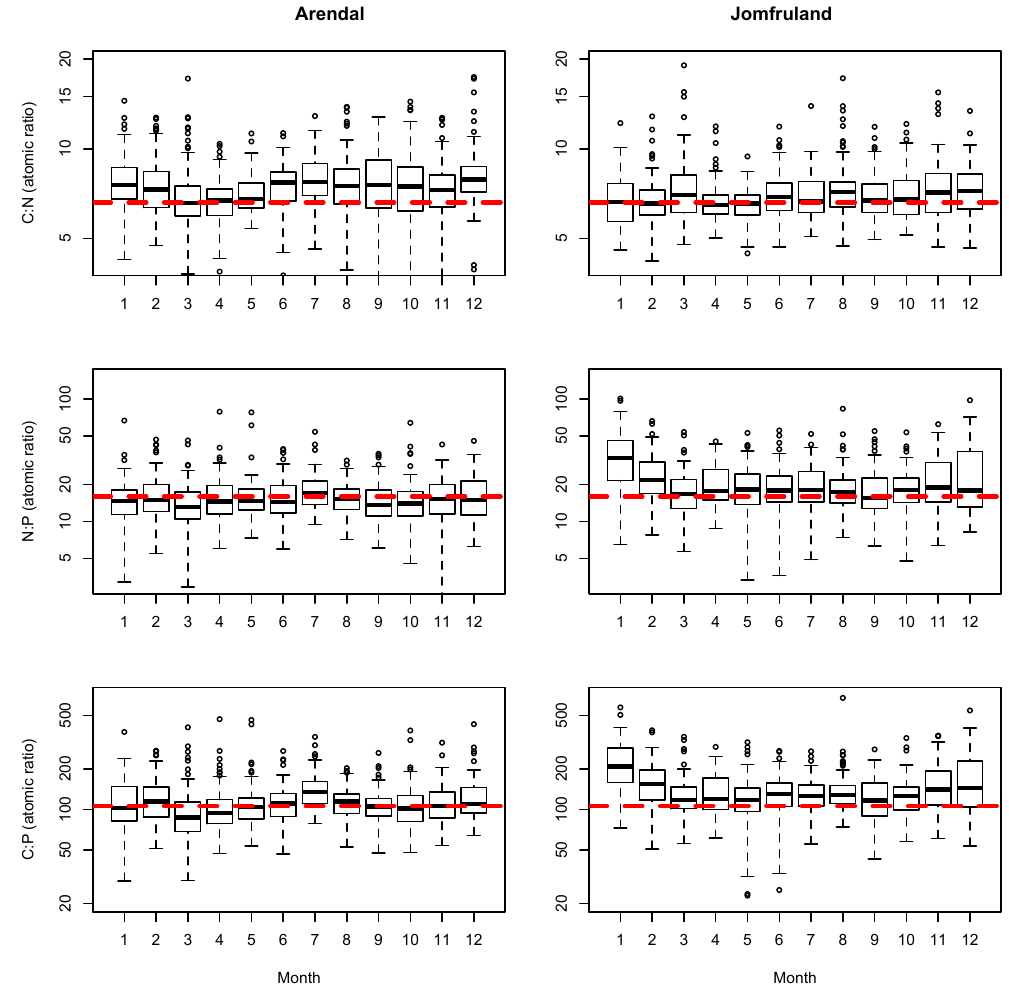
Fig. 4. Box-and-whisker plots showing the seasonal ratios of C:N, N:P and C:P (atomic ratios) for Arendal and Jomfruland. Dashed red lines show Redfield ratios and the y-axes are log-scaled.